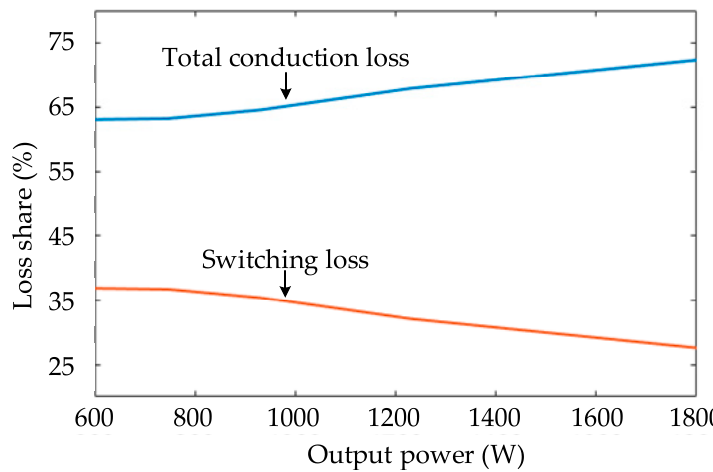
Figure 17. The share of switching loss and total conduction loss.